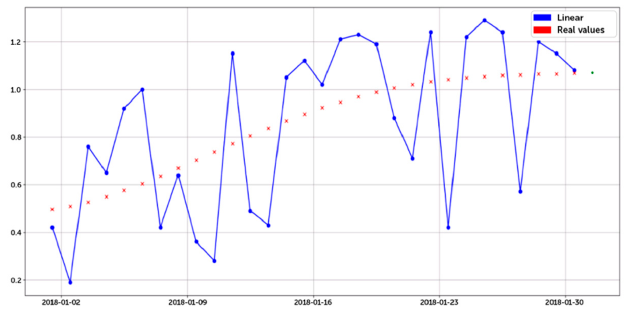
Figure 8. Task 3: sensor real-values (red dots) and their still insufficient linear predictive model (blue lines-at-step) employing a training time series of thirty days.